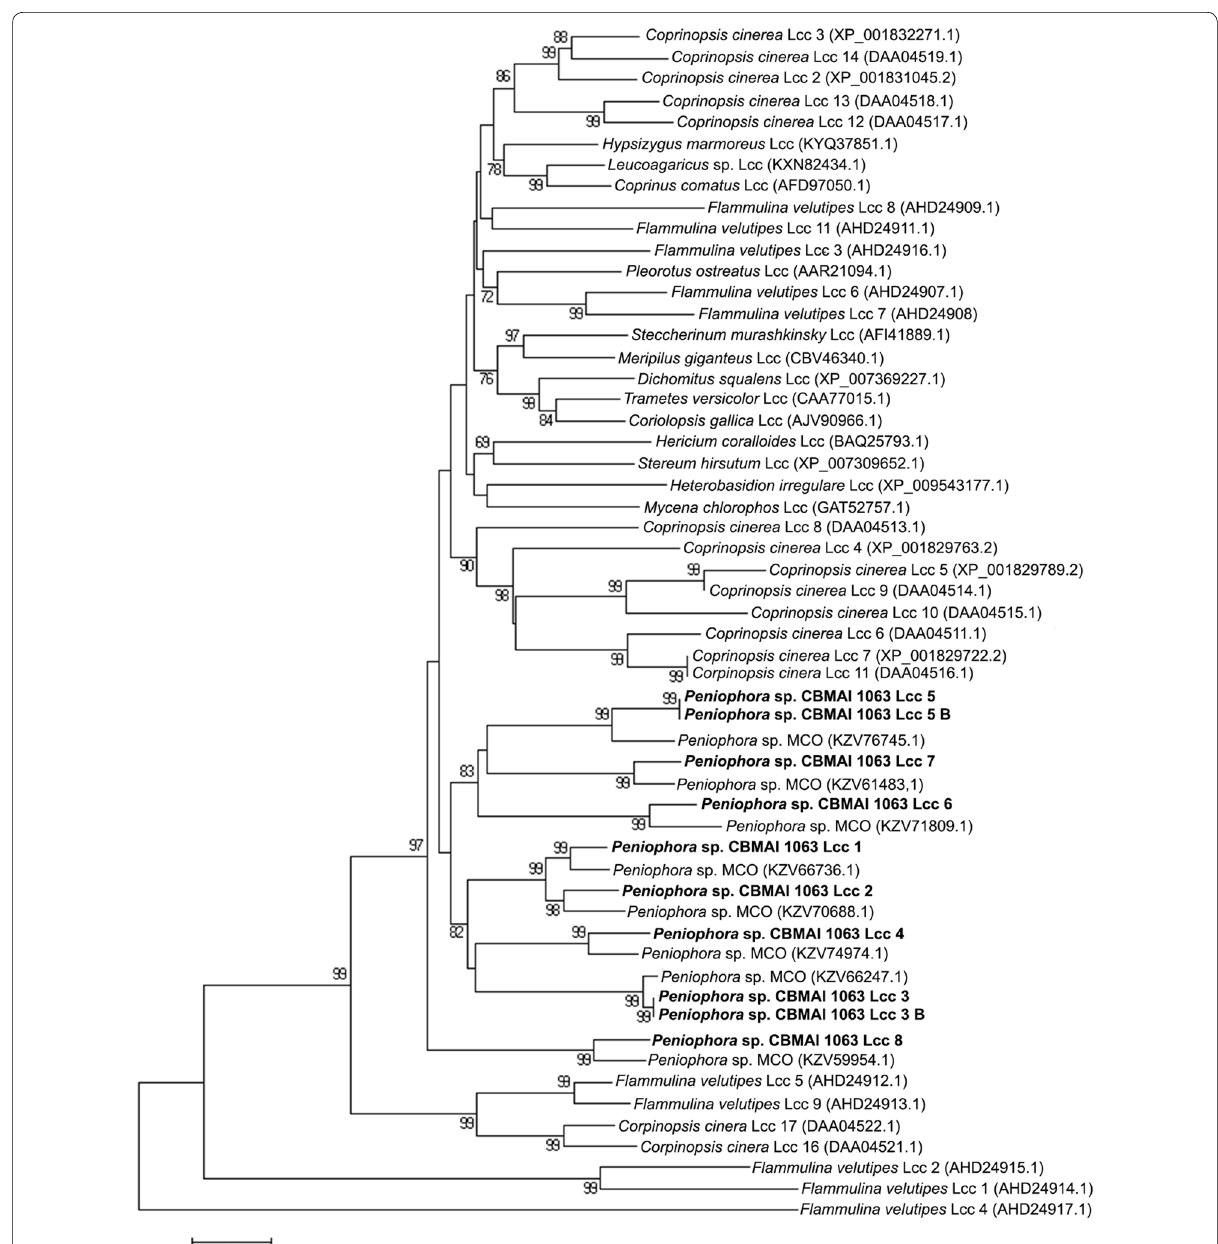
Fig. 2 Phylogenetic tree based on the Lcc1 to Lcc8 sequences, other basidiomycete laccases and putative multicopper oxidases from Peniophora sp. (see Nagy et al. 2015). Two complete laccase families from Flammulina velutipes and Coprinopsis cinerea are presented in the tree. The scale bar indicates a distance equivalent to 0.1 amino acid substitutions per